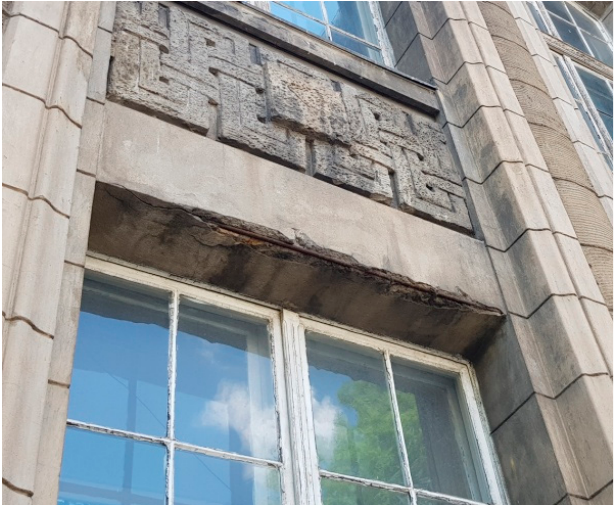
Figure 7. Damage to the layer around the reinforcement—visible rebars. Numerous cavities and areas replastered with secondary cement mortar are visible on all facades of the building (Figure 8).